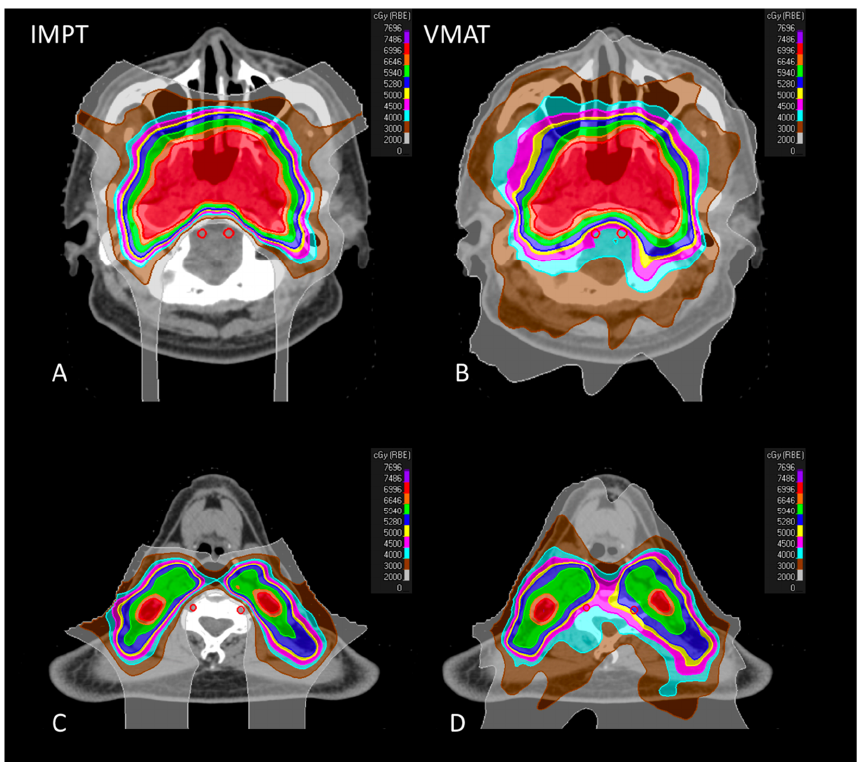
Figure 2. Representative axial CT images of colorwash dose distribution comparison for IMPT (left side) and VMAT (right side) plans of the same patient. 2 A : the dose distribution located at skull base level IMPT; 2 B : the dose distribution located at skull base level VMAT; 2 C : the dose distribution at the level of the fourth cervical vertebra of IMPT; 2 D : the dose distribution at the level of the fourth cervical vertebra of VMAT.